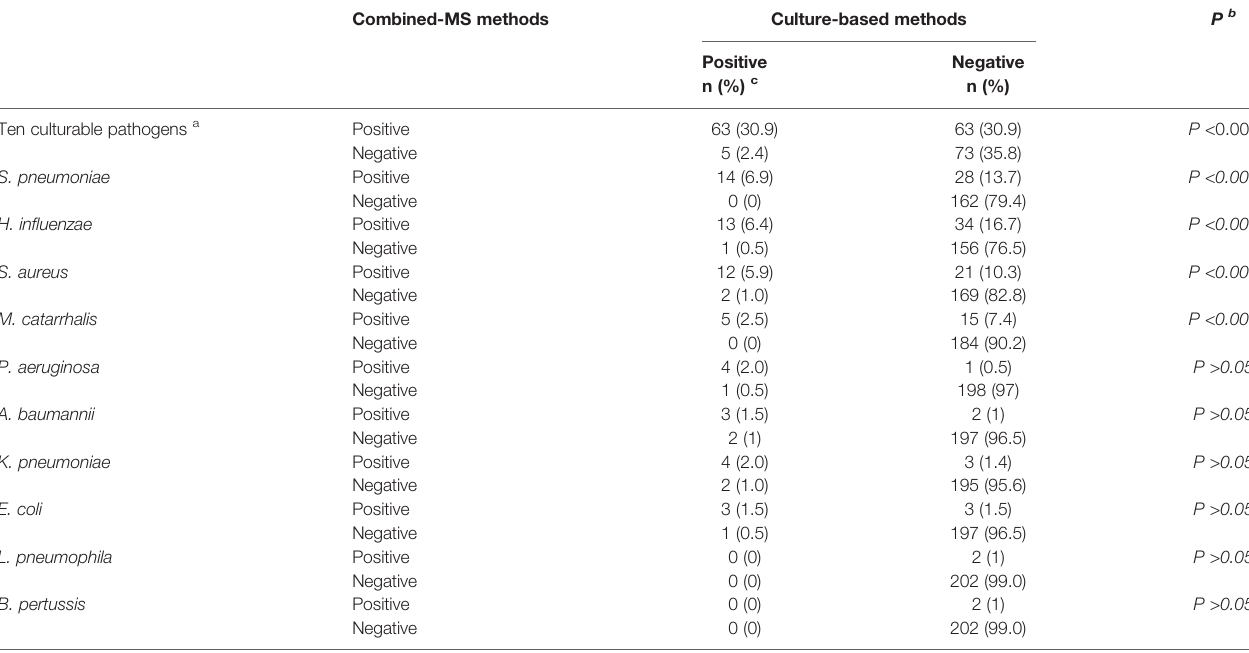
TABLE 3 | Comparison of the performance between combined-MS methods and culture-based methods (n = 204). Combined-MS methods Culture-based methods P b Positive Negative n (%) c n